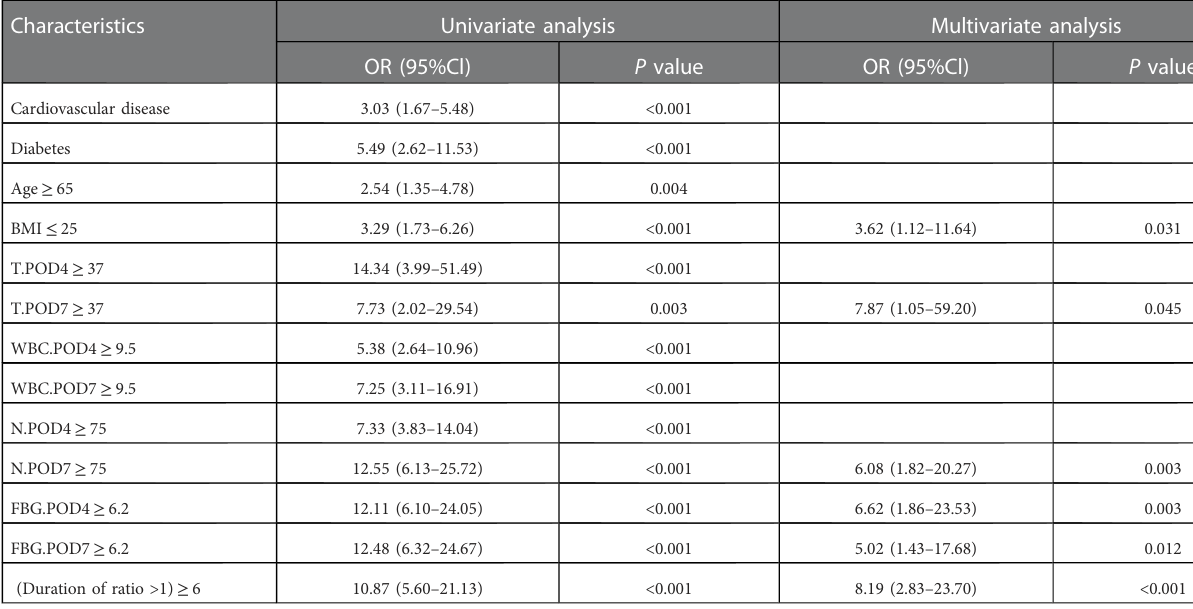
TABLE 6 Univariate and multivariate analysis for POD30 complication in the training set.